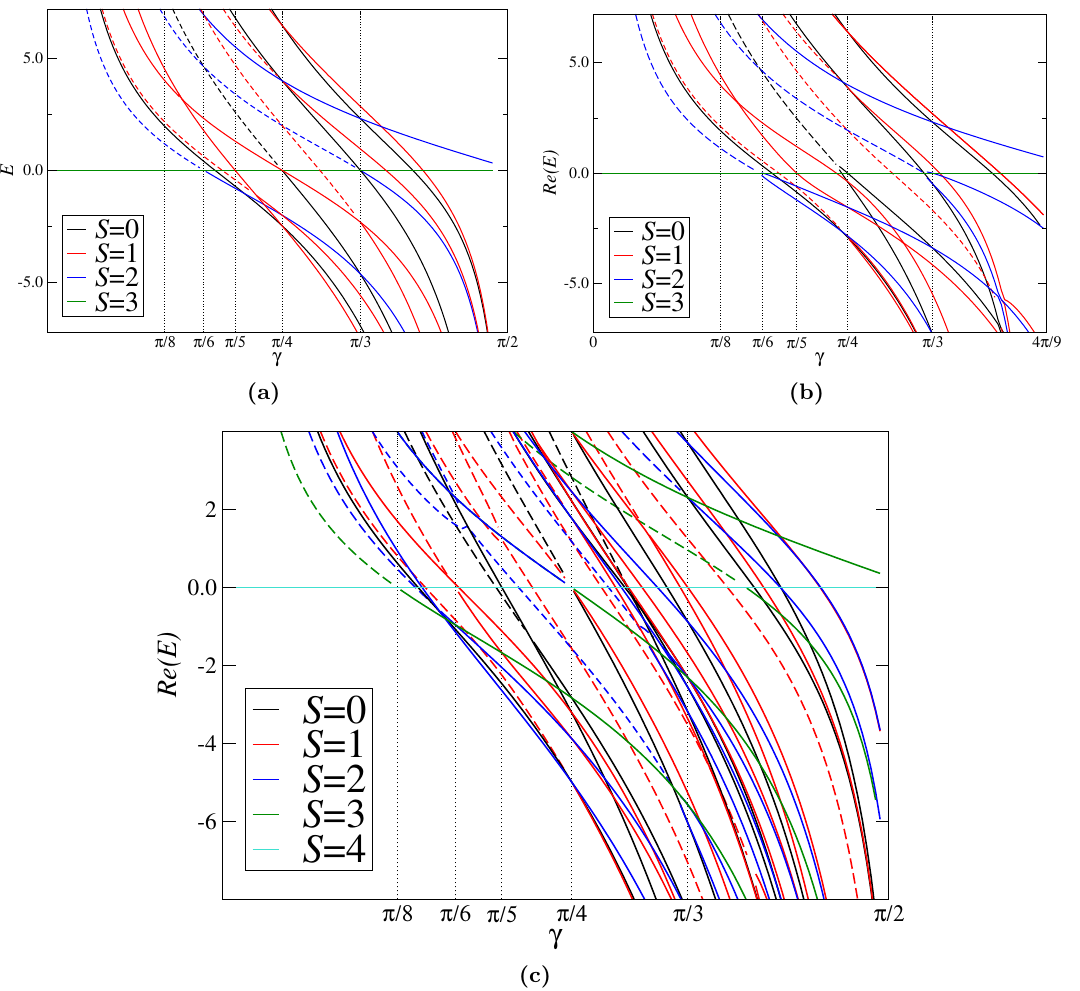
Figure 5 . (a) Spectrum of the Hamiltonian for L = 3 and α = π/ 2 , which is completely real for this choice of parameters. The solid lines indicate levels with real quasi-momentum, while the dashed ones represent a purely imaginary quasi-momentum. The colours indicate the quantum number S , i.e. the highest S z of the multiplet leading to the displayed energy level. (b) Real part of the spectrum of the model with staggering α = 9 π/ 4 and L = 3 . Notation as used in figure 5a. (c) Real part of the spectrum of the self-dual model α = π/ 2 for L = 4 . Same Notation as in 5a. We see a new ground state crossing appearing at γ = π/ 8 in comparison to the L = 3